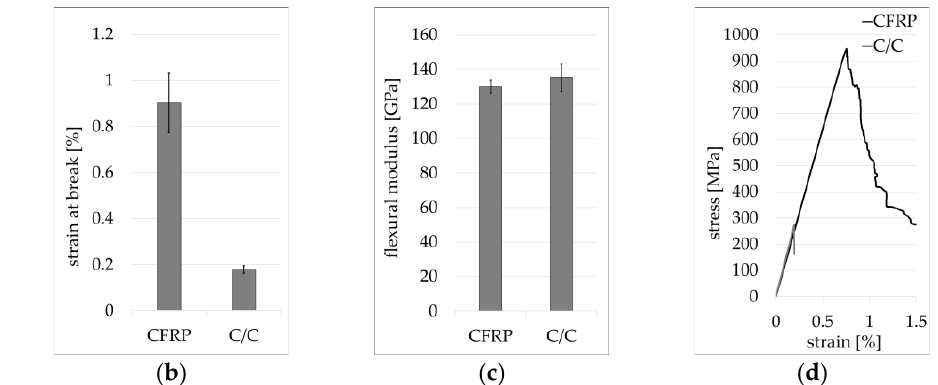
Figure 9. Mechanical properties of CFRP and C/C composites determined by four-point bending tests: ( a ) flexural strength; ( b ) strain at break; ( c ) flexural modulus; ( d ) typical stress – strain curves. The failure of the CFRP composites occurs mainly due to compressive stresses and interlaminar shear stresses, whereas the C/C composites fail due to tensile stresses (Figure 10).